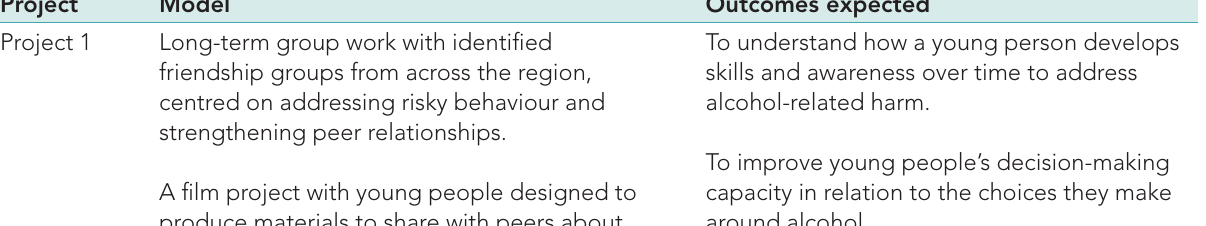
Table 2. The projects and their intended outcomes (Source: Author, 2022)